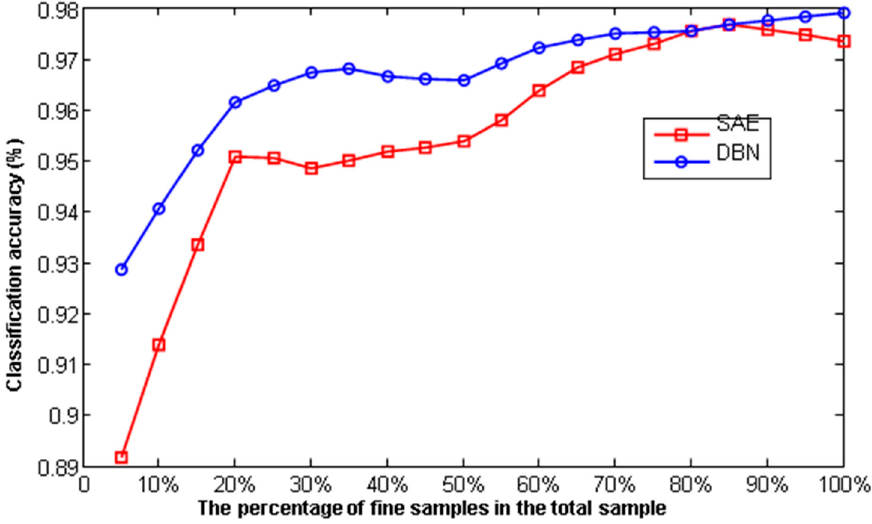
Figure 15. The classification accuracy is changed with the fine-tuning sample size.